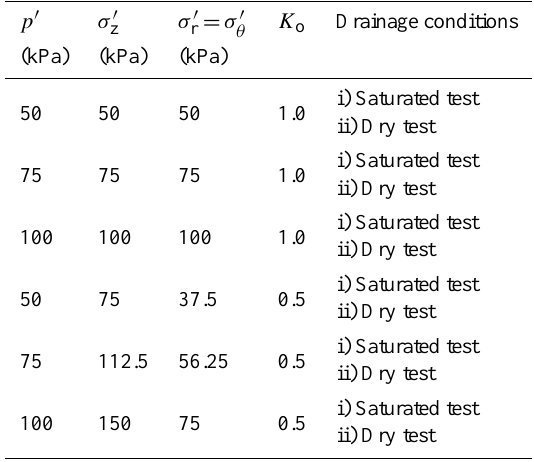
Fig. 5. Stress paths during consolidation and monotonic torsional shear. Figure 5. Stress paths during consolidation and monotonic torsional shear. 3 Table 2. Consolidation conditions for each test material prior to